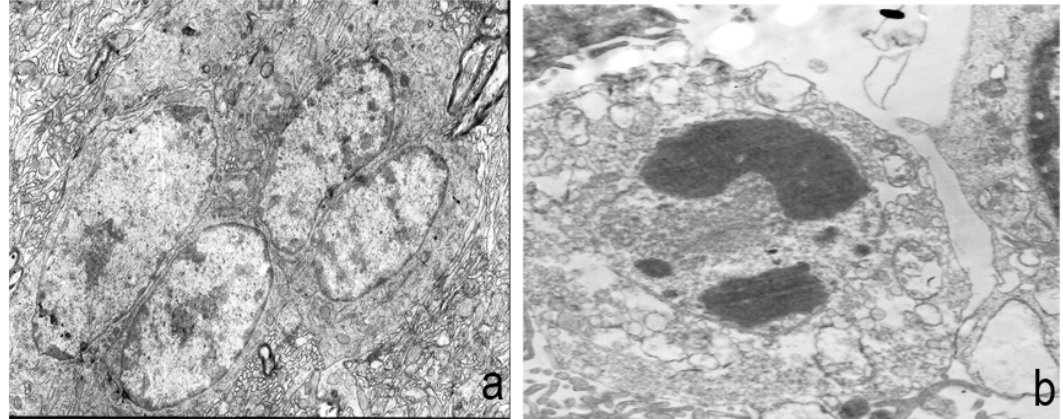
Figure 3 - Cell morphology and nucleus in the exhaustive exercise group. a, multicells are shown in the micrographs; b, one cell is shown in the